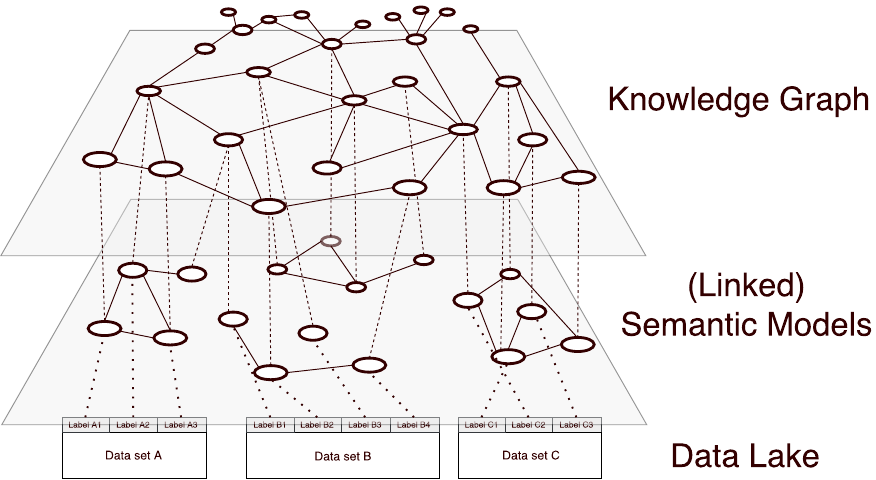
Figure 6. Overview of the three-layered information storage model containing the raw data at the lowest level, attached semantic models and topped by the knowledge